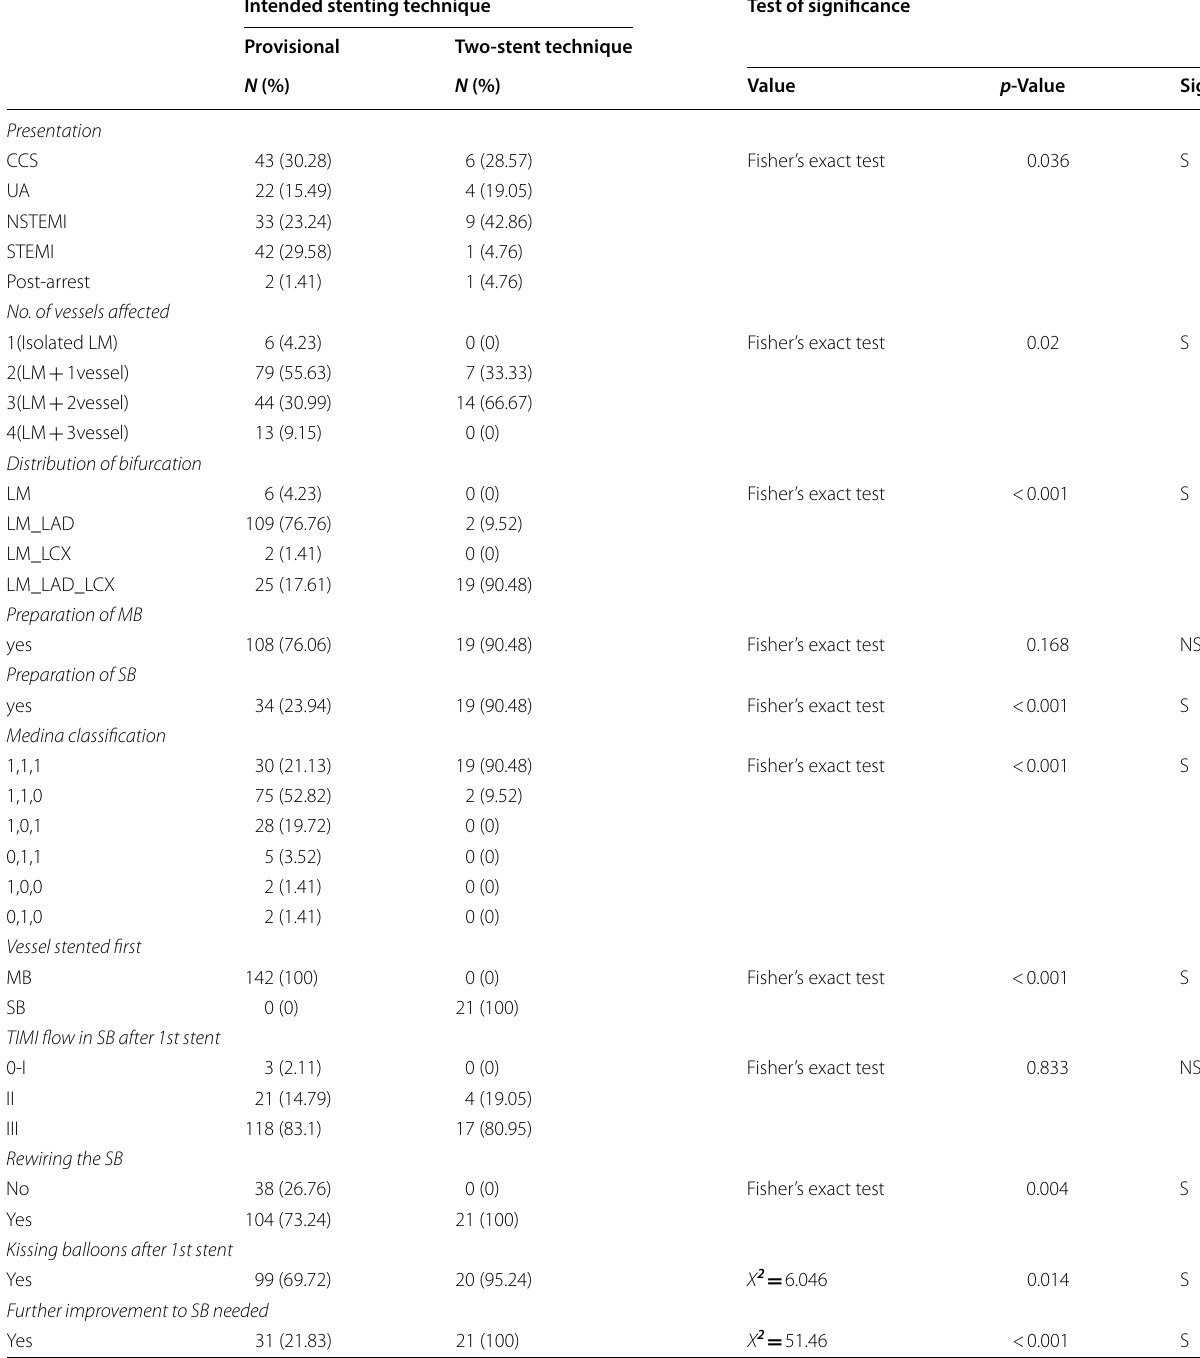
Table 3 Procedural and technical